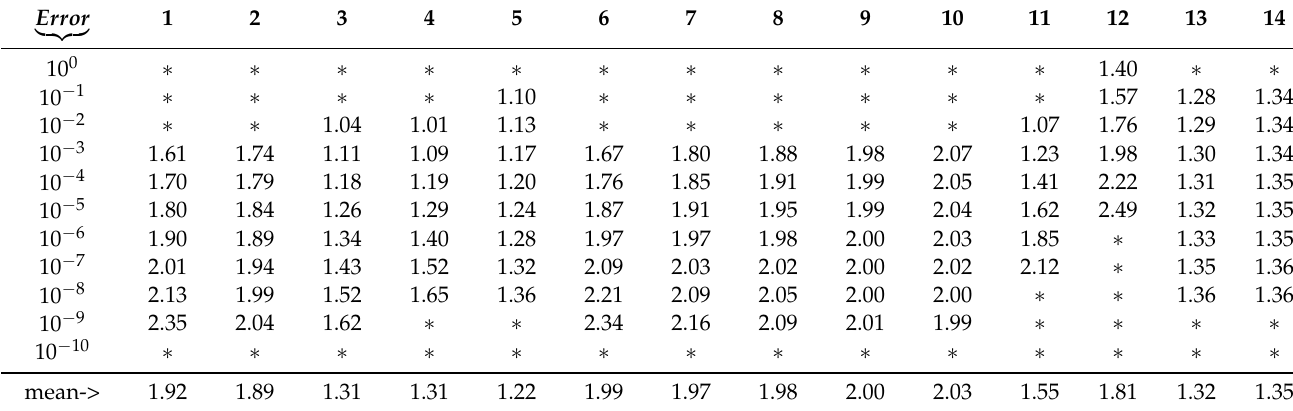
Table 7. Efficiency ratios of DP5(4) vs. NEW(4) for various problems and global errors achieved over the whole integra- tion interval. Stars indicate unavailability of data to attain the perspective errors. Error (cid:124) (cid:123)(cid:122) (cid:125)